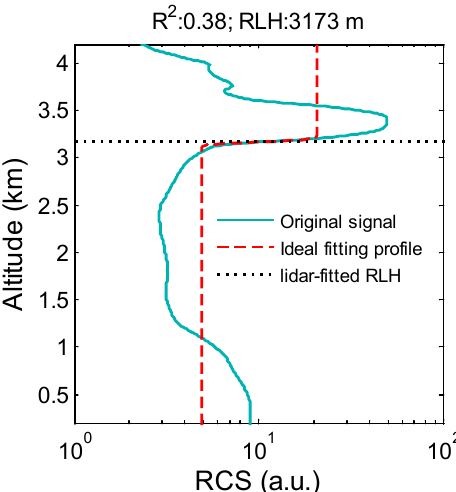
Figure 5 . RLHs determined with the IPF method with Lidar-measured RCS at 23:28, 12 May 2015 (CST). The signal corresponds to the black dotted line in Figure 4.